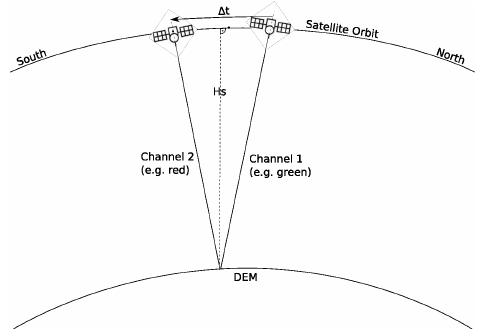
Figure 5: Principle of acquisition geometry of image bands sepa- rated in a FPA